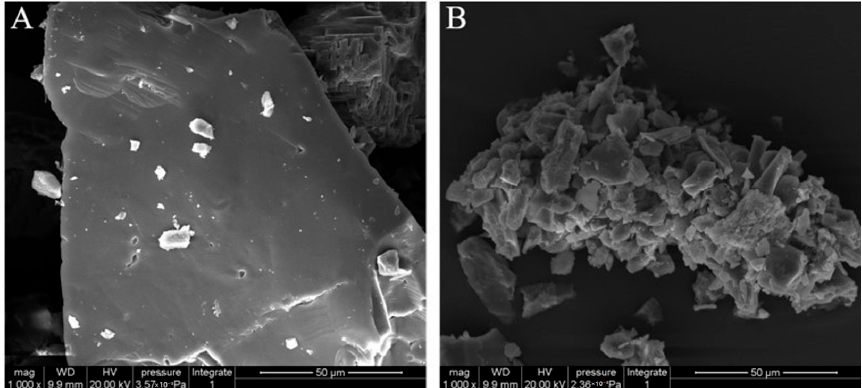
Figure 3. Scanning electron micrograph of dissolution of potassium feldspar after inoculation with B. aryabhattai SK1-7. ( A ) Potash feldspar surface in the blank control treatment. ( B ) Potash feldspar surface in the group treated with B. aryabhattai SK1-7.